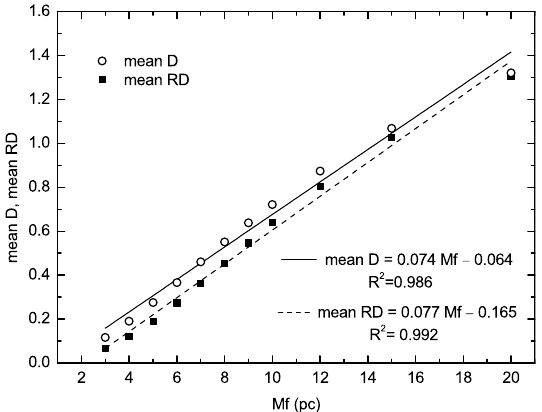
Fig. 7. Variation of the mean D and RD as a function of scale factor Mf . Both dependencies can be well fitted by linear laws. Their equations are given in the figure. The Pearson significance of the approximations is R 2 > 0 :